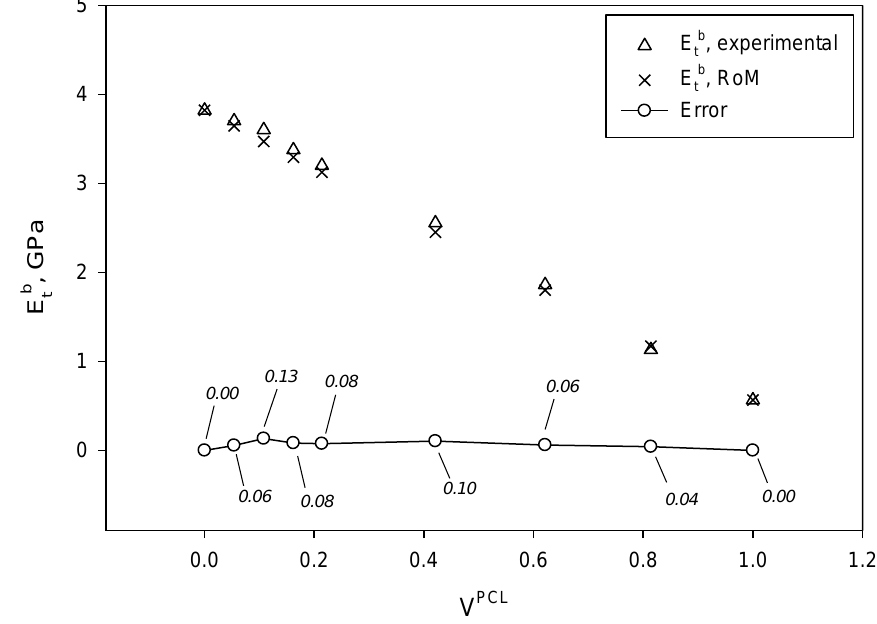
Figure 7. Experimental Young’s modulus of the PLA / PCL blends compared to the computed values through RoM.